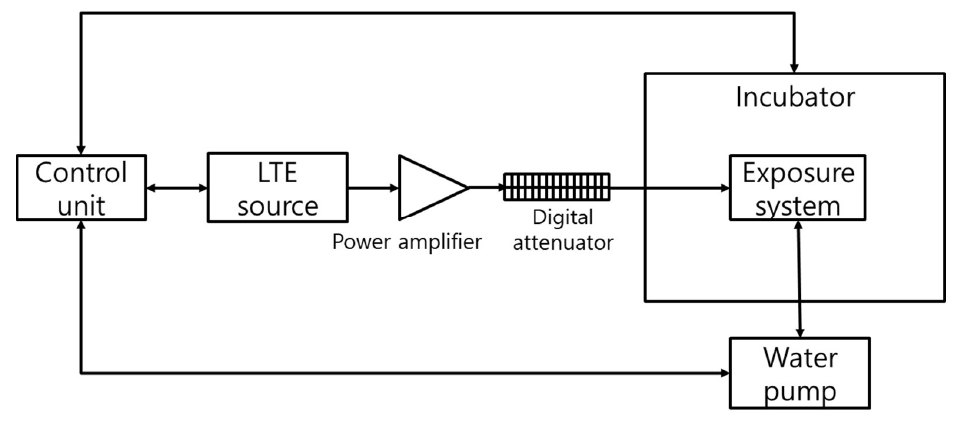
Scheme 1. Diagram of LTE exposure